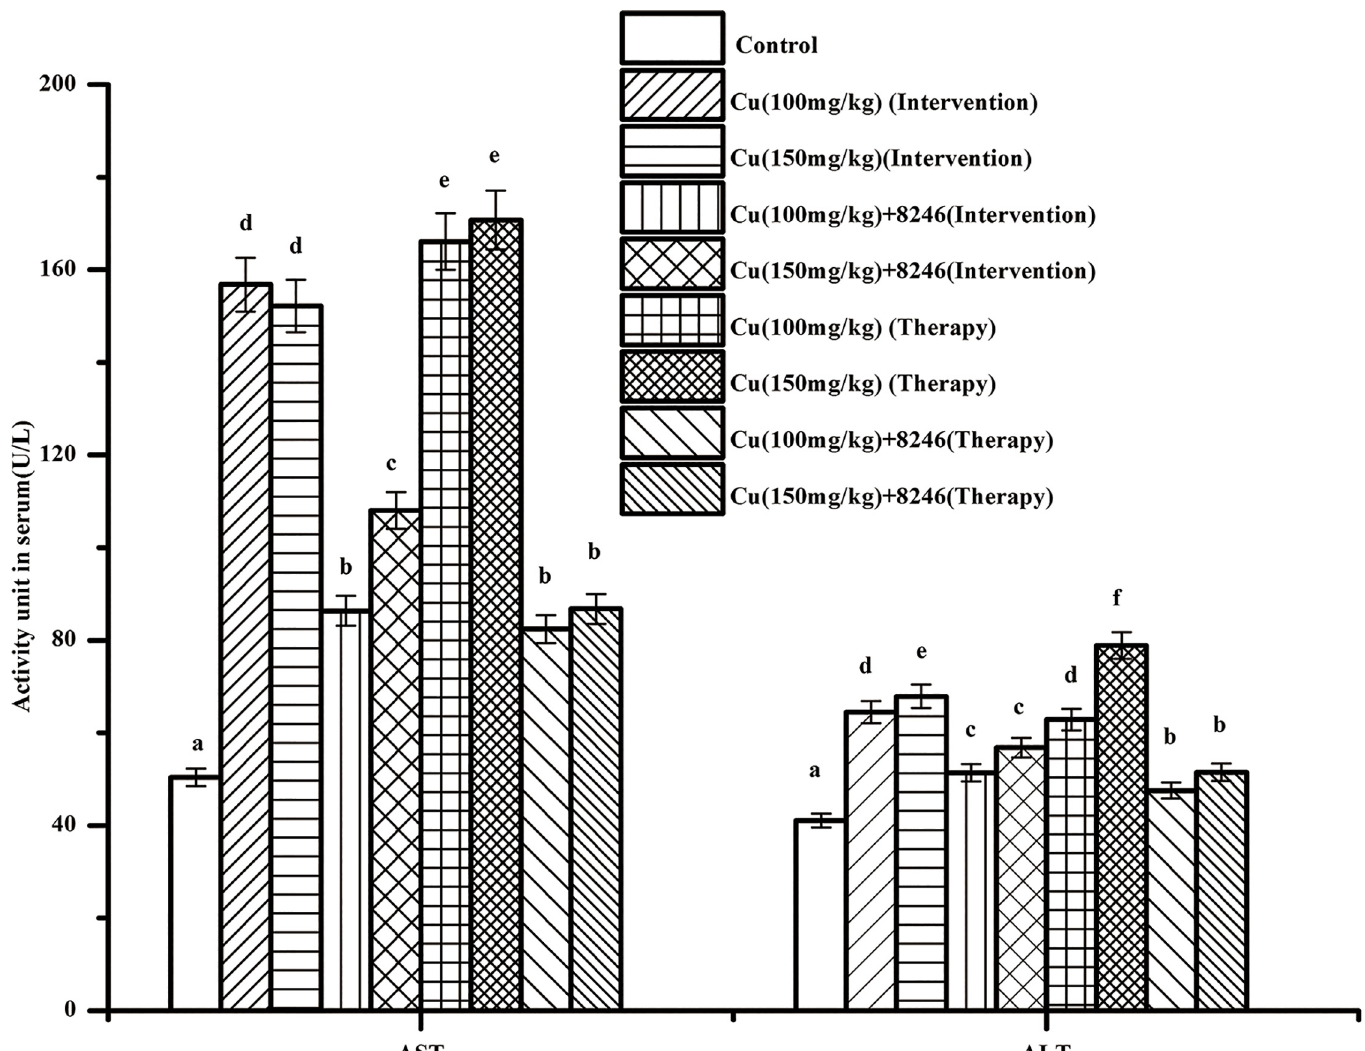
Fig 8. The activity of ALT and AST in serum of mice. The letters a, b, c, d, e and f mean that for each index, groups with different letters differ significantly ( p <